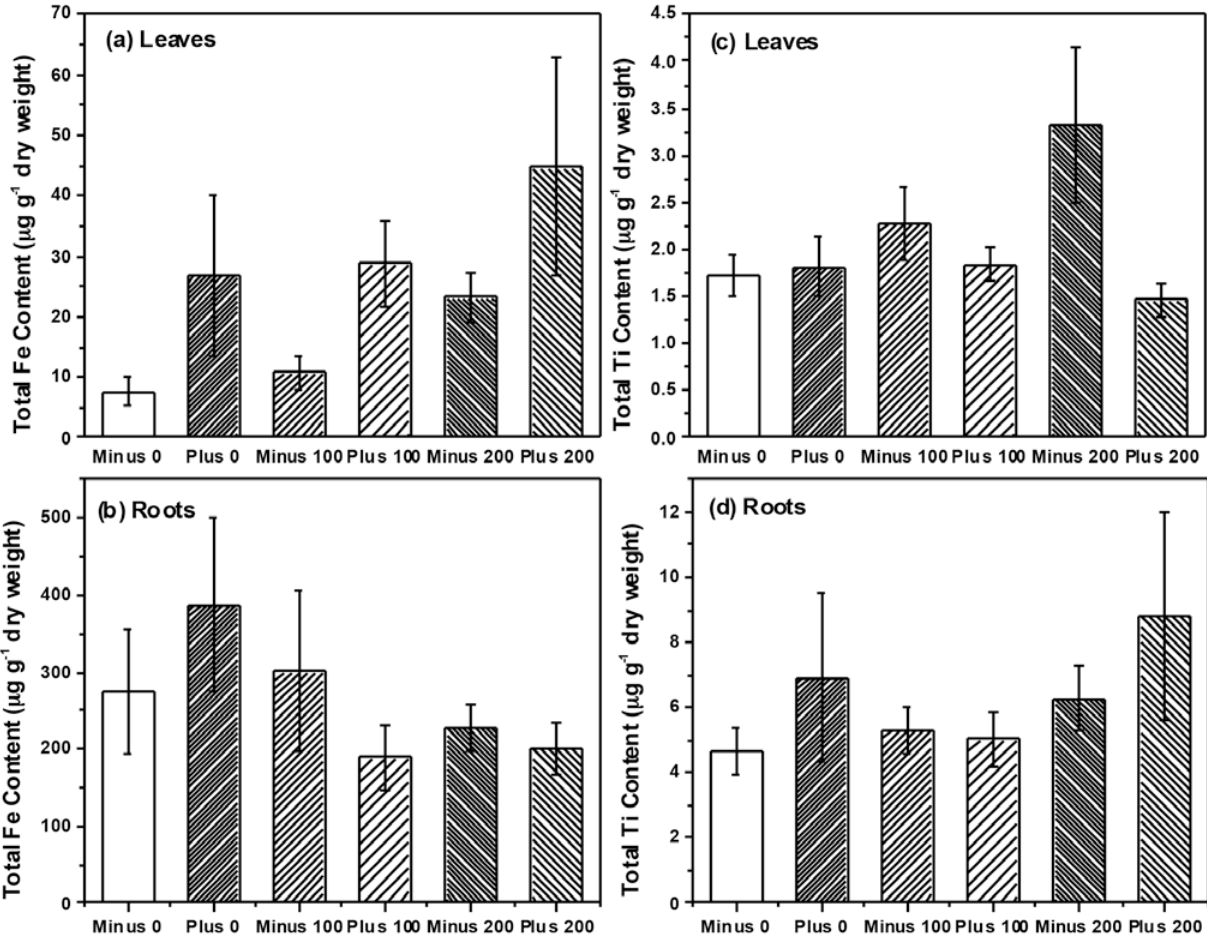
Figure 4. Total amount of Fe found in leaves ( a ) and roots ( b ) and the total amount of Ti found in leaves ( c ) and roots ( d ),